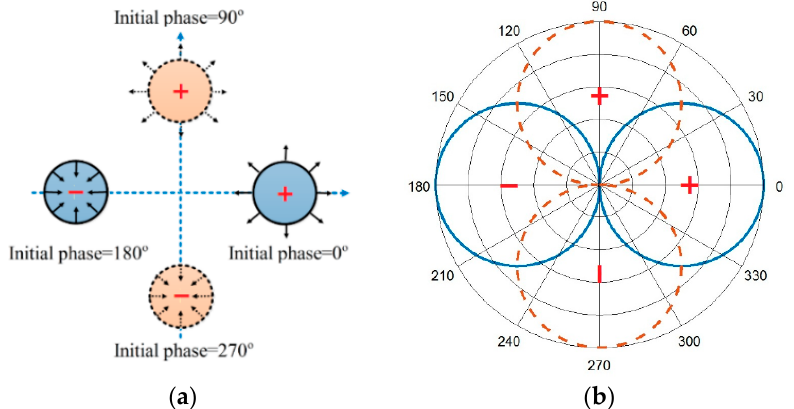
Figure 1. ( a ) The permutation of the four-point sound sources and their initial vibration phase in the x - y planes; ( b ) The directivity of the two pairs of sound sources.